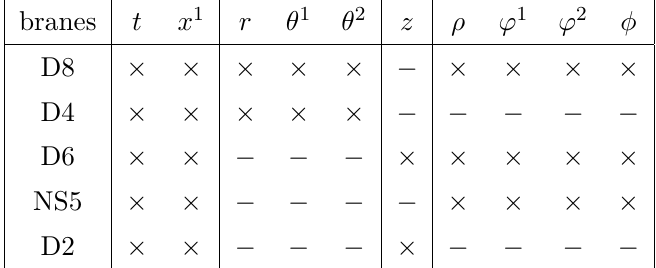
Table 5 . Brane picture underlying the intersection of D2-NS5-D6 branes ending on the D4-D8 brane system. The system is BPS / 8